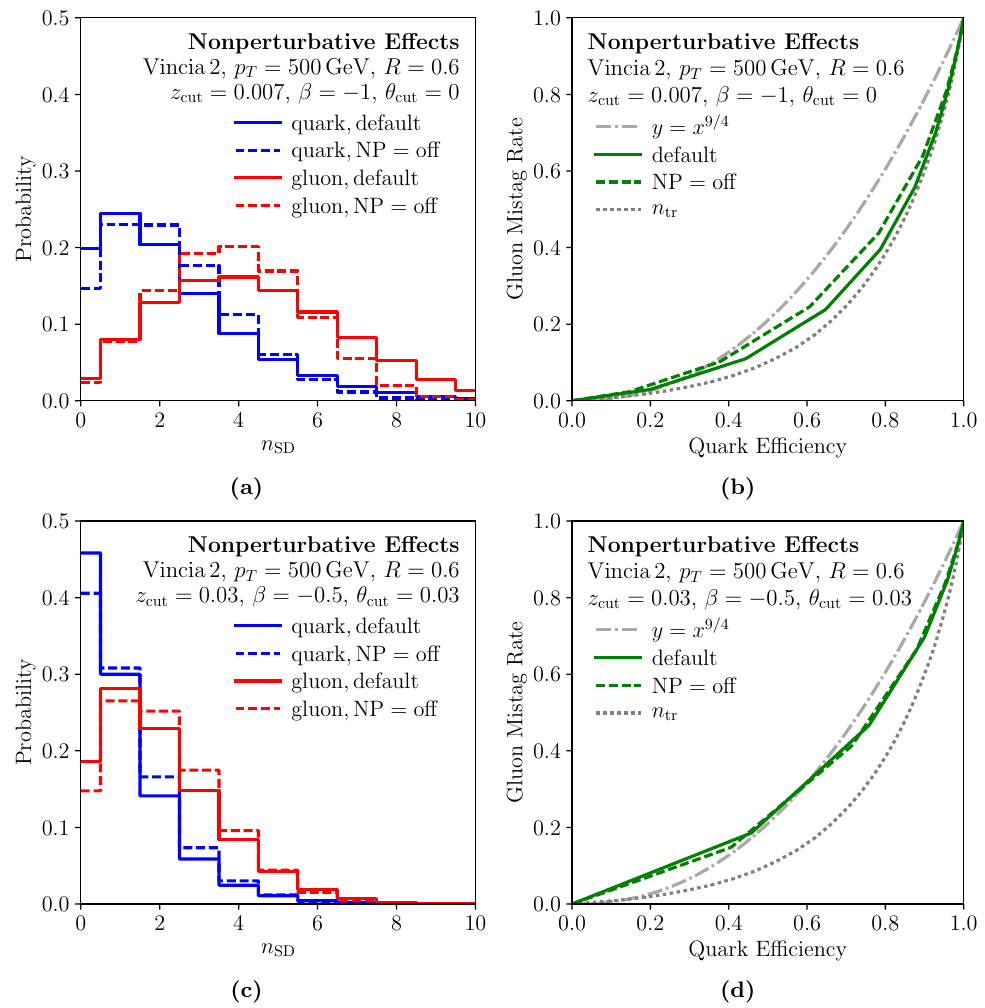
Figure 12. Impact of nonperturbative e(cid:11)ects on (left column) n the corresponding ROC curves. This study employs Vincia , where parameters are chosen according to eqs. (3.17), (3.18) and (3.20) with (cid:3) NP = 2 GeV and (top row) (cid:12) = (cid:12) = 0 : (cid:0)